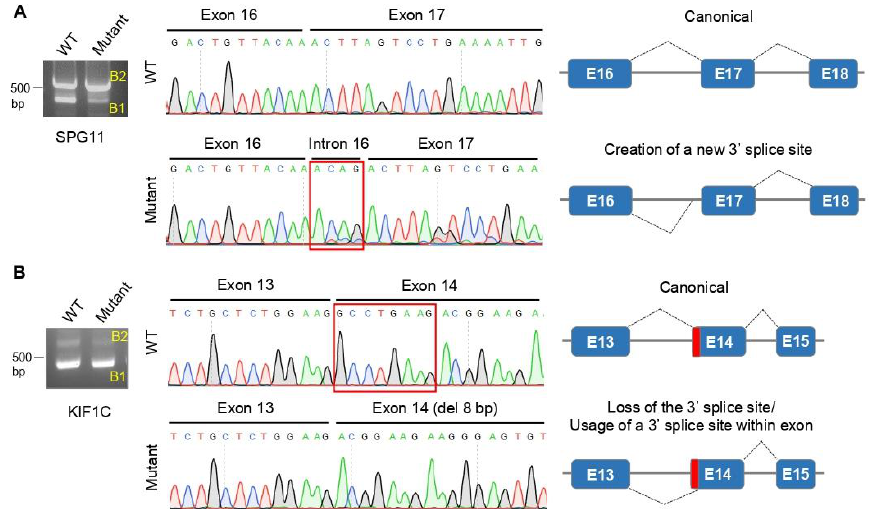
Figure 1. Analysis of SPG11 (c.3039-5T > G) ( A ) and KIF1C (c.1166-2A > G) ( B ) splice-site variants, with minigene splicing assays. Agarose gel electrophoresis of the transcripts generated by the wild- type (WT) and mutant minigene constructs (on the left): B1 bands (<500 bp) represent transcripts affected by the variants; B2 bands (>500 bp) represent amplified transcripts with intron retention, not affected by the variant. Sanger sequencing of the transcripts corresponding to B1 bands (in the middle). Schematic representation of resulting splicing events (on the right): ( A ) SPG11 variant creates a new 3 (cid:48) acceptor splice site, resulting in the retention of 4 nucleotides of intron 16; ( B ) KIF1C variant abolished the 3 (cid:48) acceptor splice-site, leading to the usage of a splice site within exon 14 and resulting in the deletion of 8 nucleotides from exon 14. Electropherograms showing the location of the splice-site variants on genomic DNA are shown in Figure S1, supporting information.